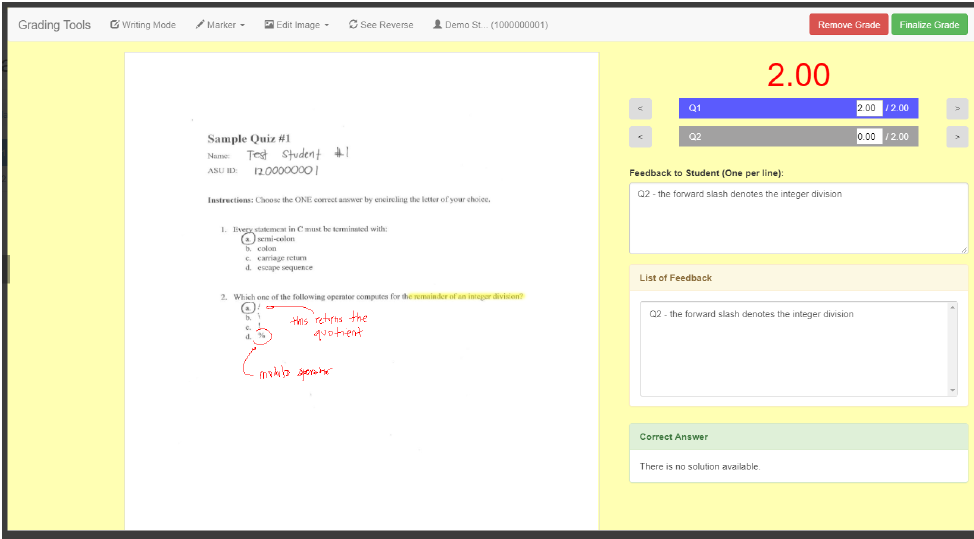
Figure 1. Grading interface provides the tools to assess students’ answers. The left panel presents the scanned image while the right panel contains the rubrics and a textbox to provide free-form